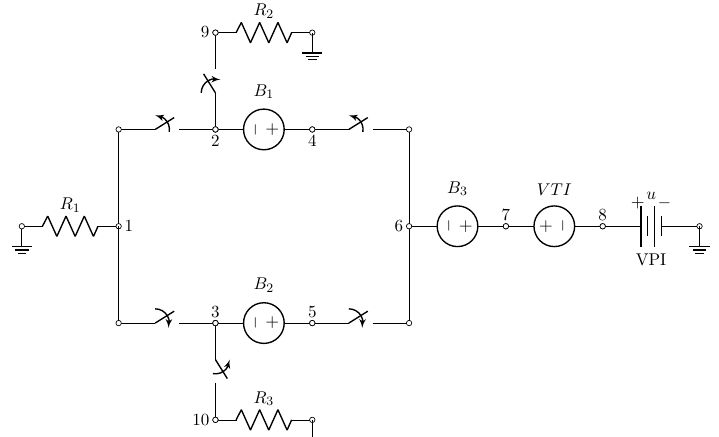
Figure 7. Circuit equivalent with a = 1